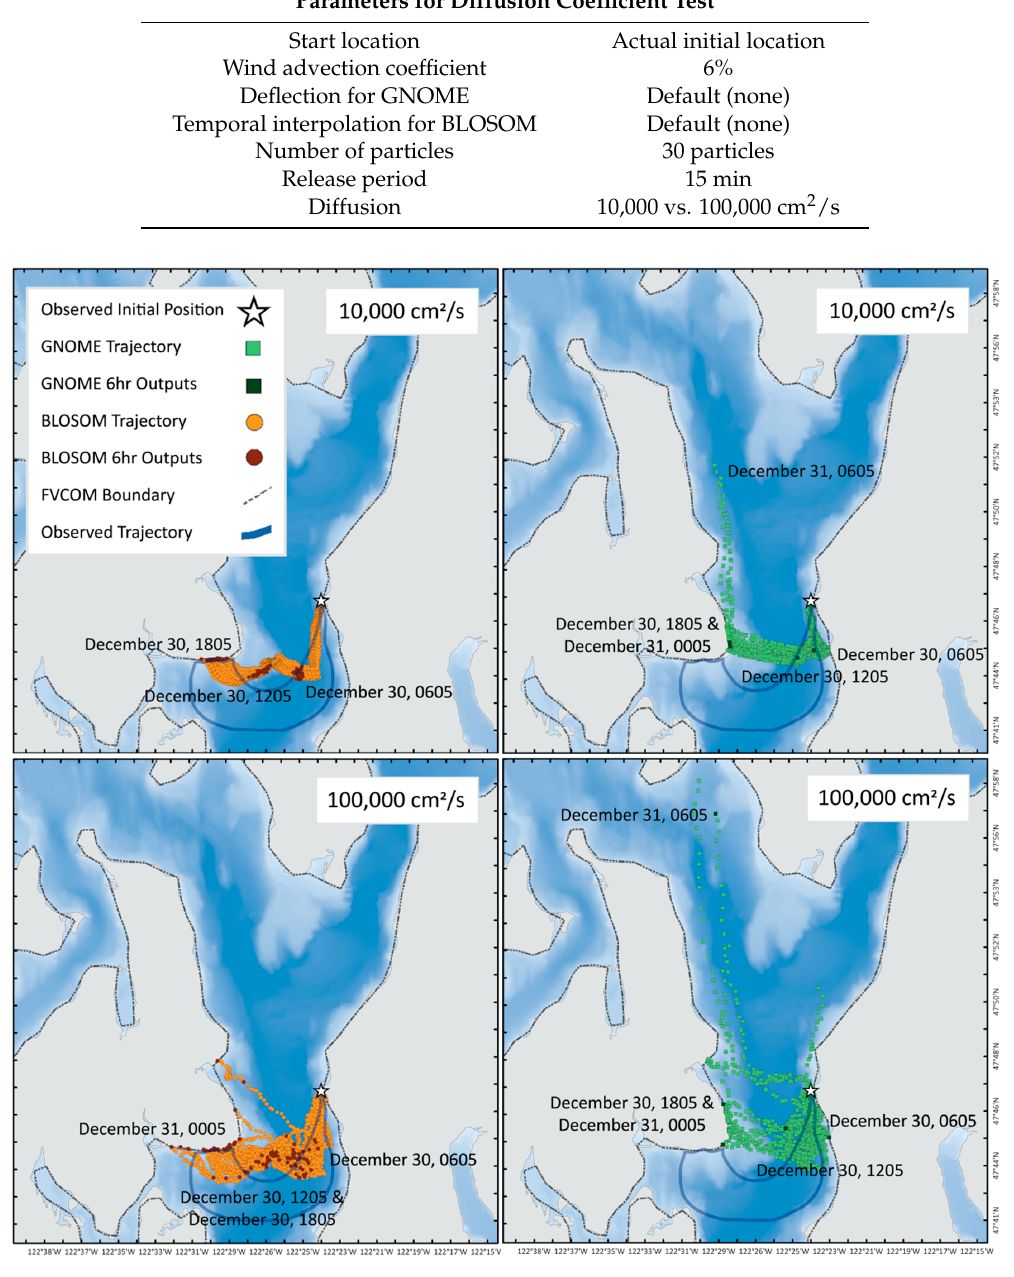
Figure 20. Comparison of diffusion coefficients; test 9.